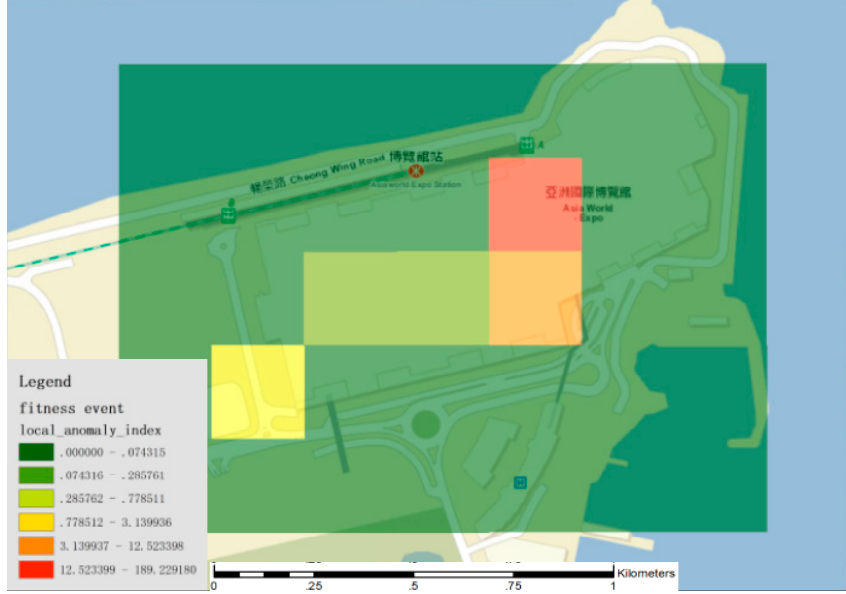
Figure 9. The Chek Lap Kok region, which shows high 𝐿𝐸𝐼 values for ‘fitness’ check-ins, indicating significant human aggregation.